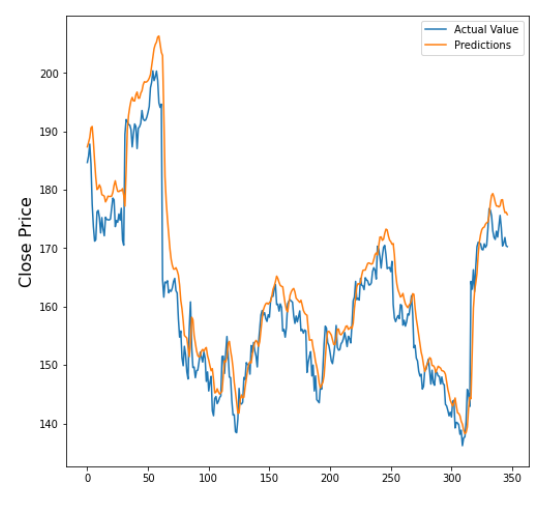
Figure 11. Prediction of Close price using ANN